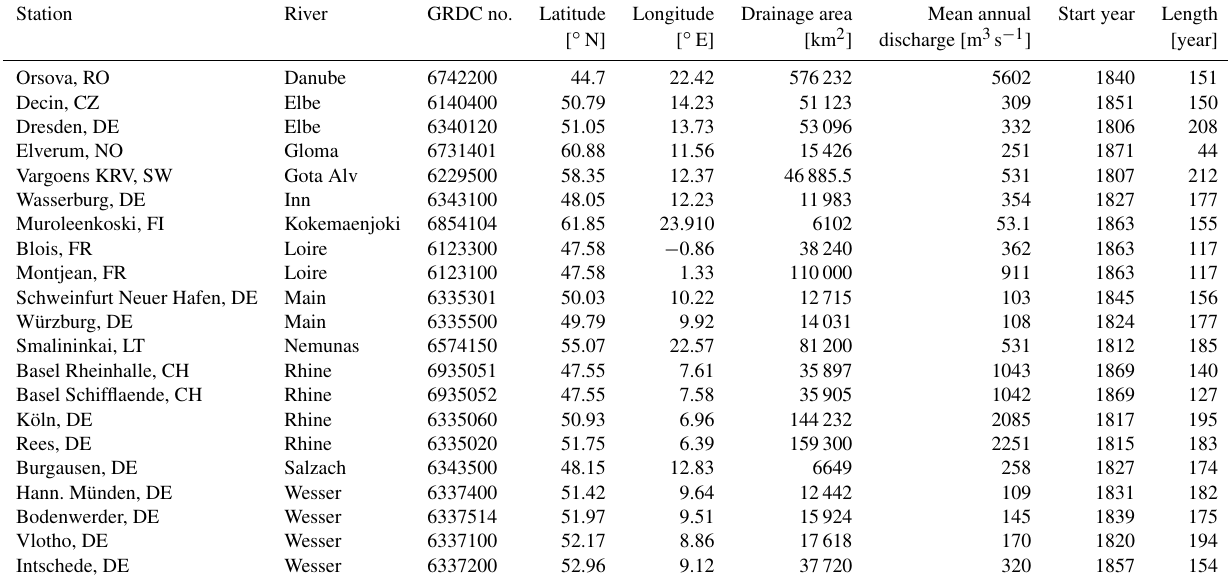
Table 2. Selected study catchments. Station Orsova,